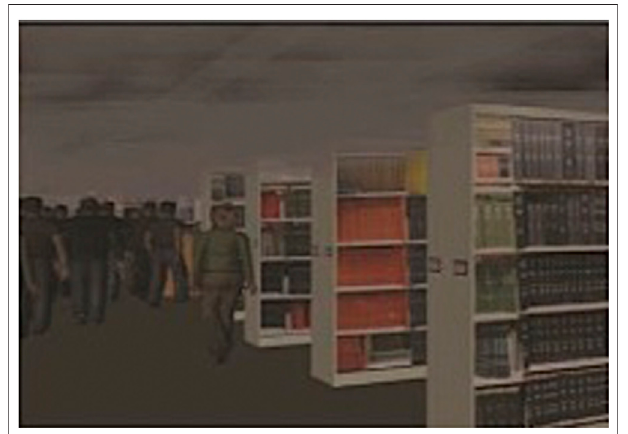
FIGURE 10 | Tucker et al. (2018) incorporated smoke only to enhance participants ’ anxiety and perceived hazard and not to the extent where the simulating impacts of smoke hinder visibility.